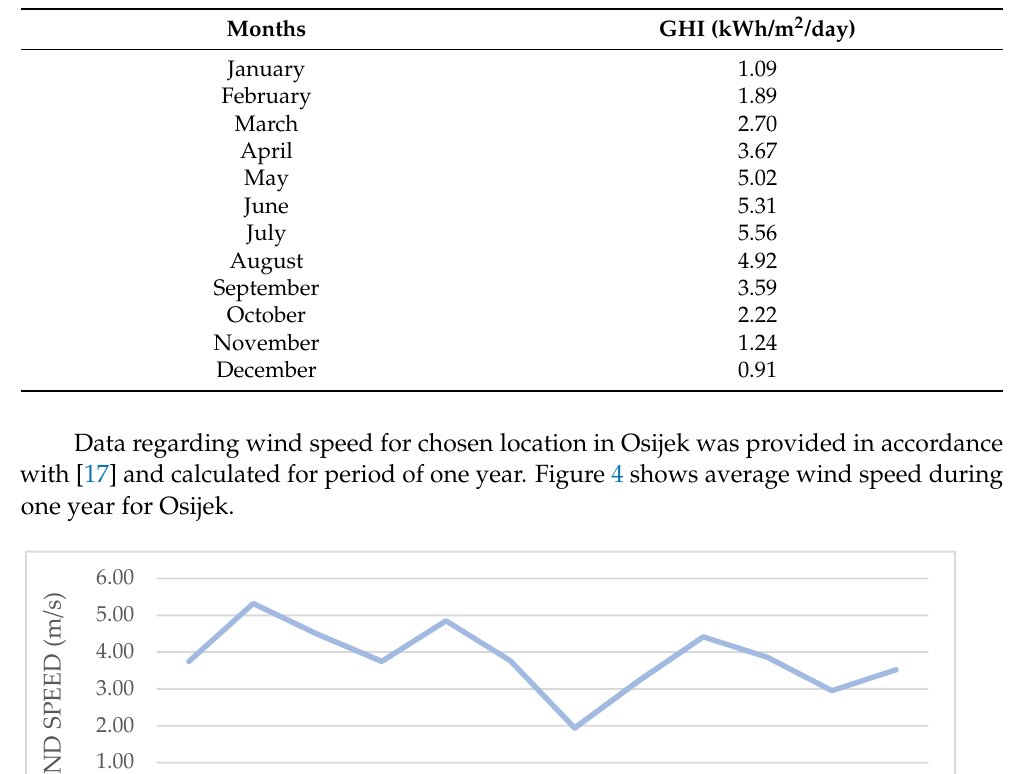
Table 1. Solar irradiance for Osijek [16].